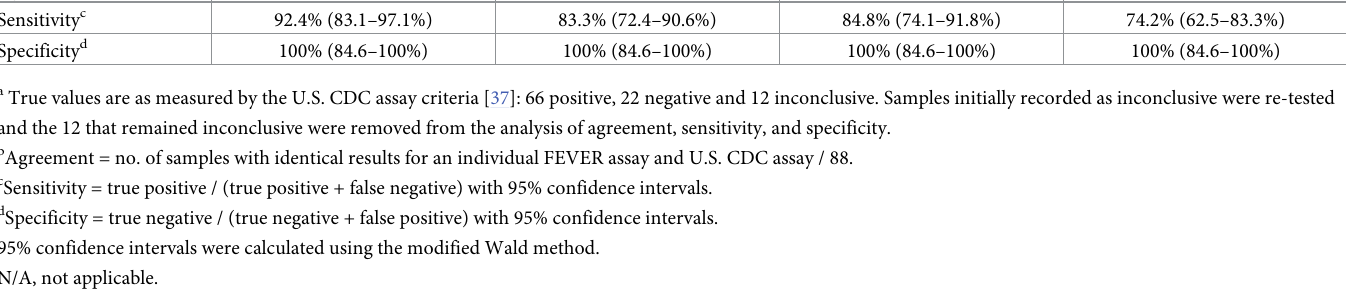
CDC assay (Fig 3). In general, a broad range of C values from 13 to 39 was observed. Interest- T ingly, one sample that originally tested positive for the U.S. CDC assay (N2) with a C value of T 34 on the ABI 7500 Fast Dx, tested negative on the ABI StepOnePlus. There was a significant ( P < 0.001), correlation between the C values of all four FEVER assays compared with each T of the U.S. CDC N1 and N2 assays indicating that when run on the same instrument the FEVER and U.S. CDC assays yield highly similar C values (Fig 3). It is unfortunate that this T